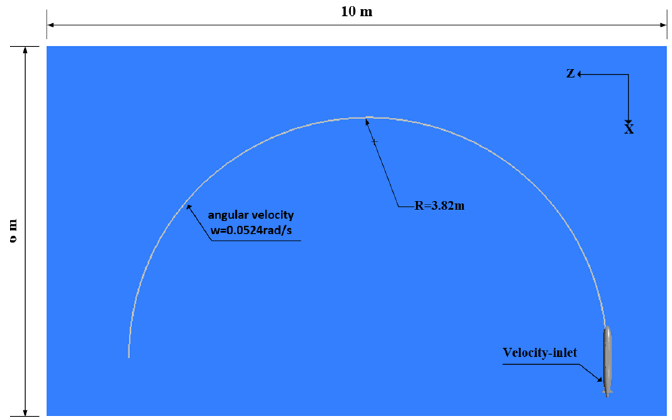
Figure 1. Model diagram of underwater vehicle rotation in uniform fresh water environment.